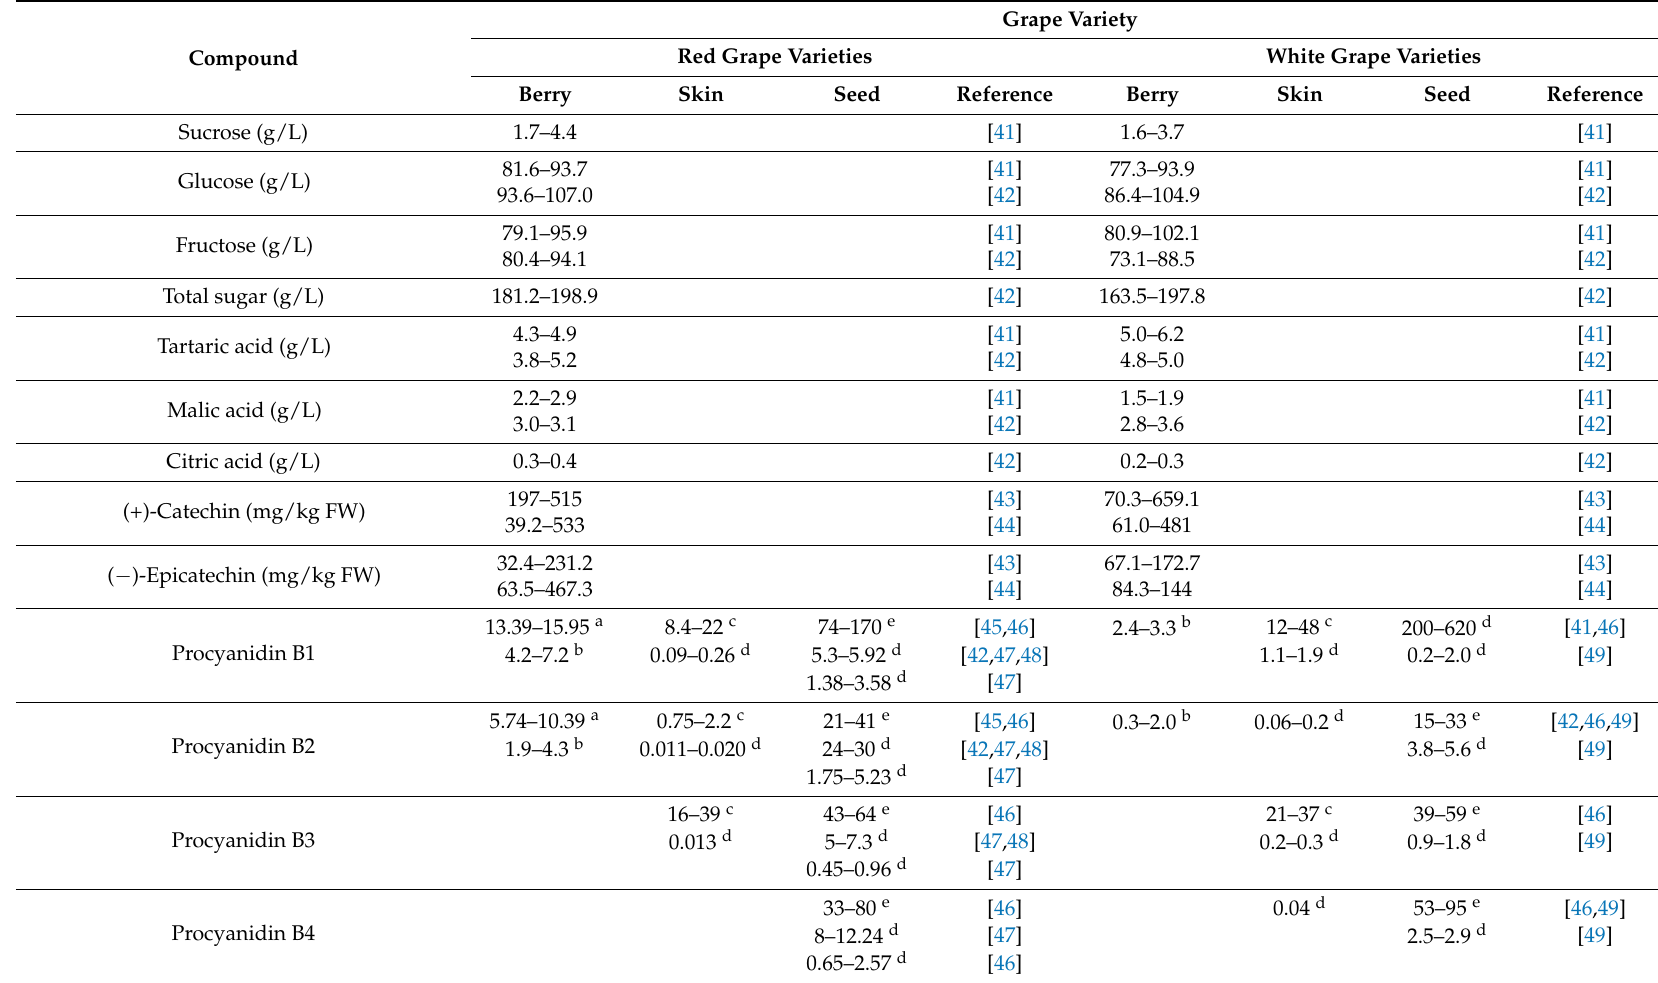
Table 1. White and red grape varieties’ chemical